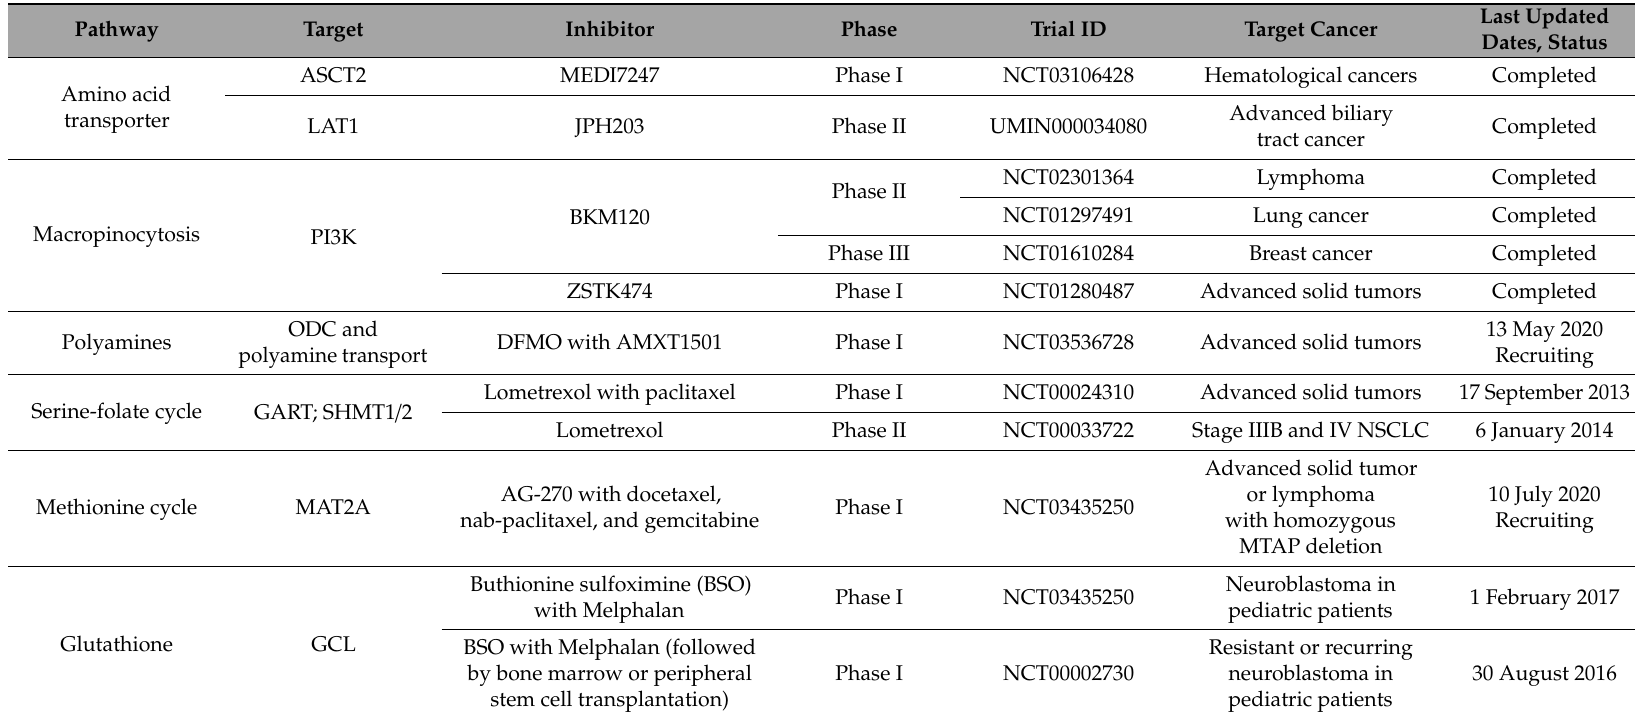
Table 1. Cancer therapeutics in clinical trials targeting amino acid